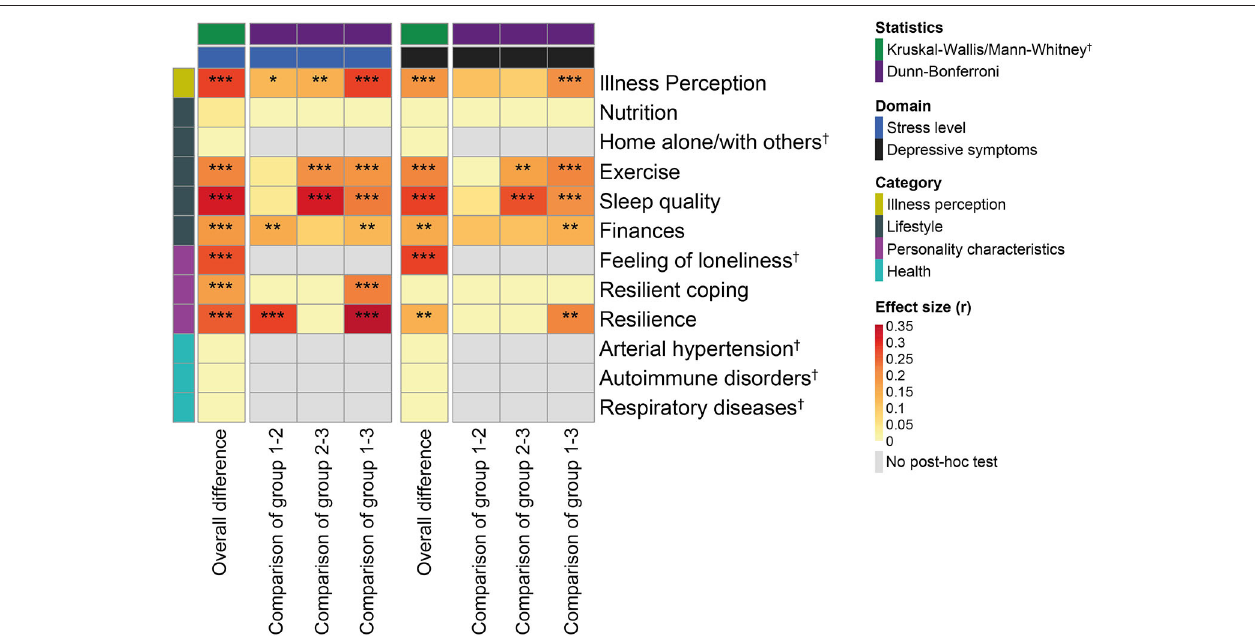
FIGURE 3 | Association between stress levels, severity of depressive symptoms, and potential underlying risk factors during the COVID-19 lockdown. Heatmap showing Pearson’s r effect sizes with levels of significance based on a Kruskal–Wallis/Dunn–Bonferroni test (with adjustment for multiple comparisons) and whenever appropriate a Mann–Whitney U -test (* P < 0.05, ** P < 0.01, *** P < 0.001). Group comparisons refer to post hoc tests where for illness perception, finances, resilient coping and resilience groups 1, 2, and 3 correspond to minor, moderate, and significant response, respectively, while for nutrition, exercise, and sleep quality groups 1, 2, and 3 correspond to improved, unchanged, and worsened response,